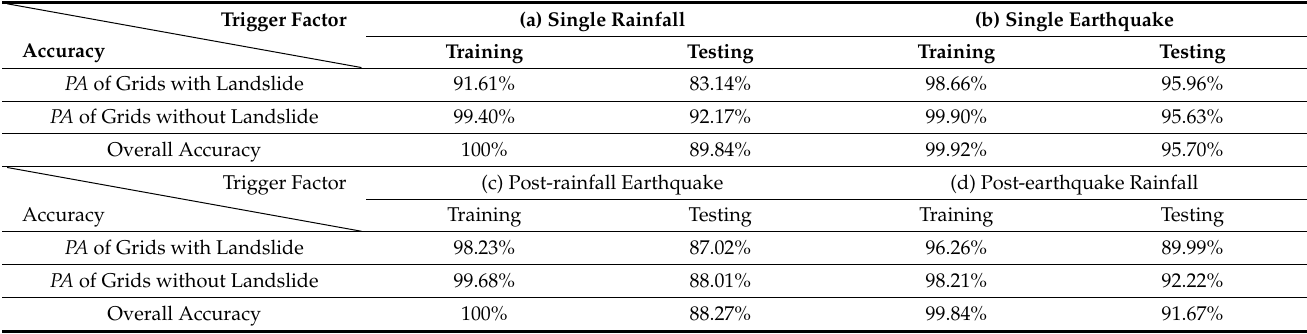
Table 7. Producer accuracy and overall accuracy for training and testing data